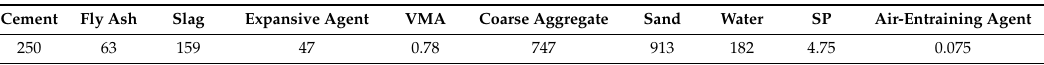
Table 2. Mix proportions of self-compacting concrete (SCC) in kg · m − 3 . VMA—viscosity modifying admixture;